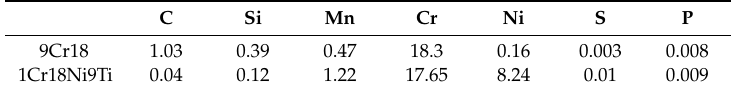
Table 2. Material chemical composition of the ball ‐ on ‐ disk configurations (weight%).